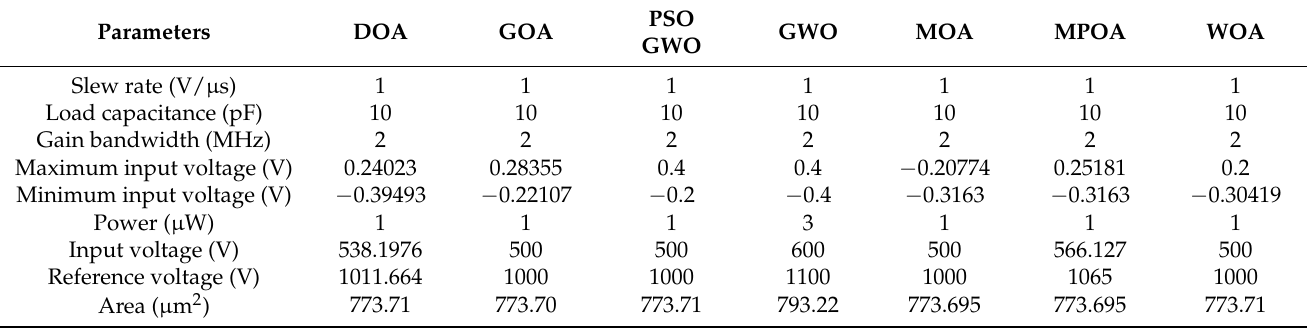
Table 3. Comparison of design variables for the implemented algorithms.